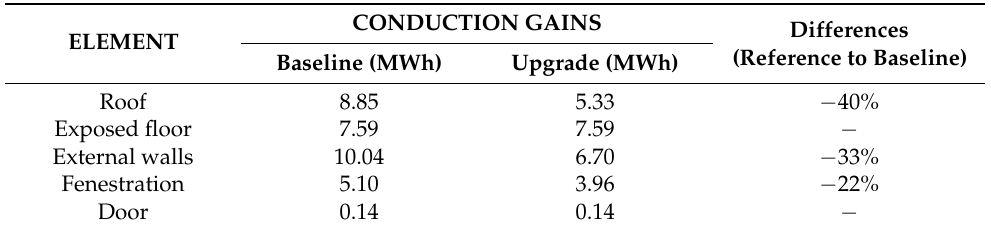
Table 13. Comparative breakdown of the conduction